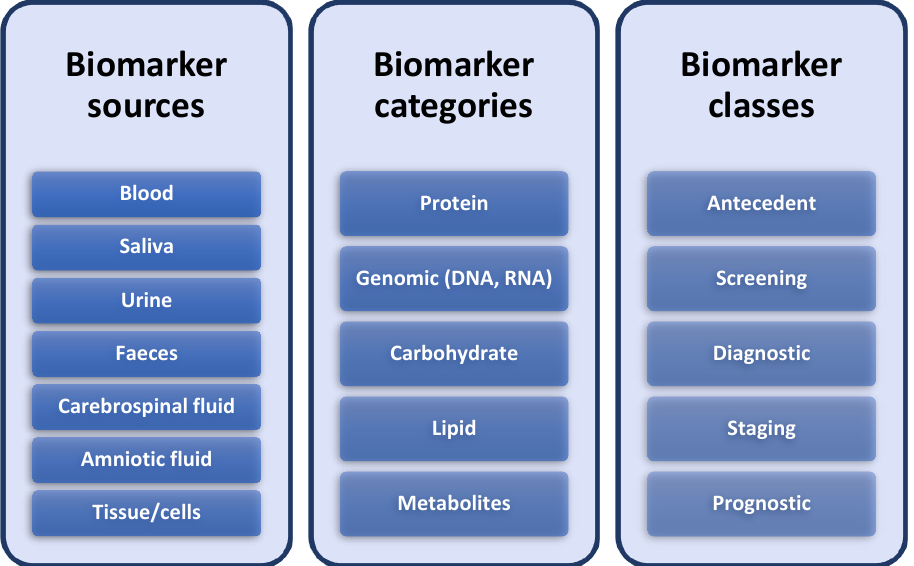
Scheme 1. Categorization of biomarkers’ sources, categories, and classes.